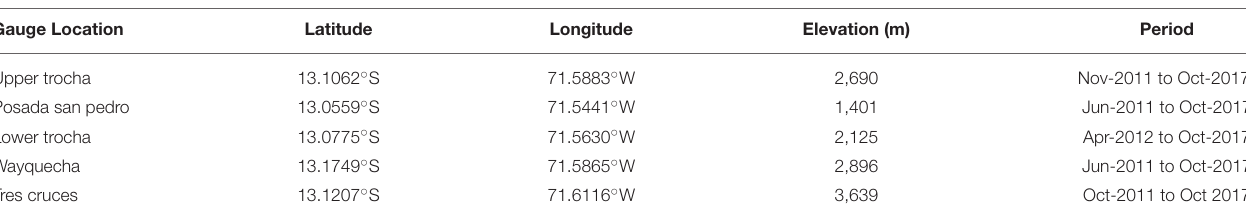
TABLE 1 | Rain gauge location and time in